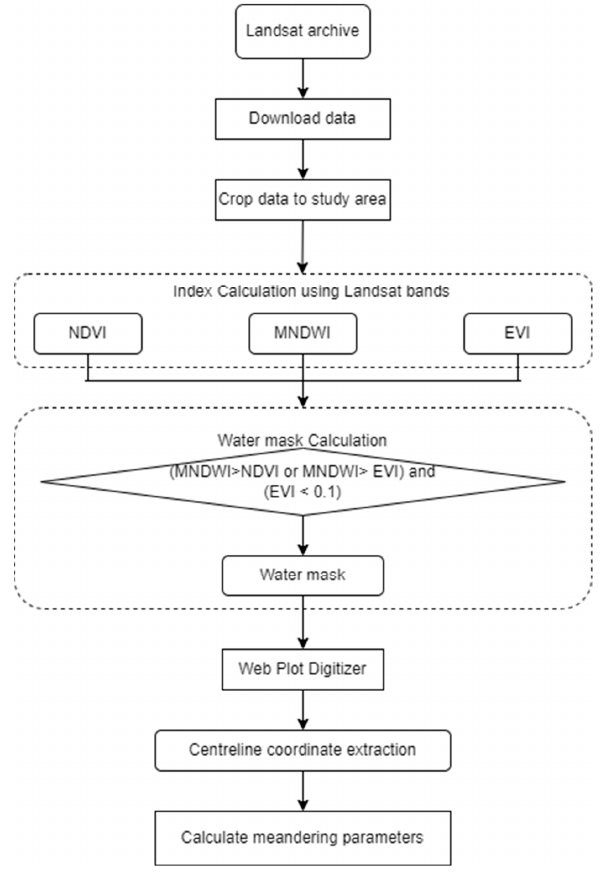
Figure 4. Overview of the methodology of the study.